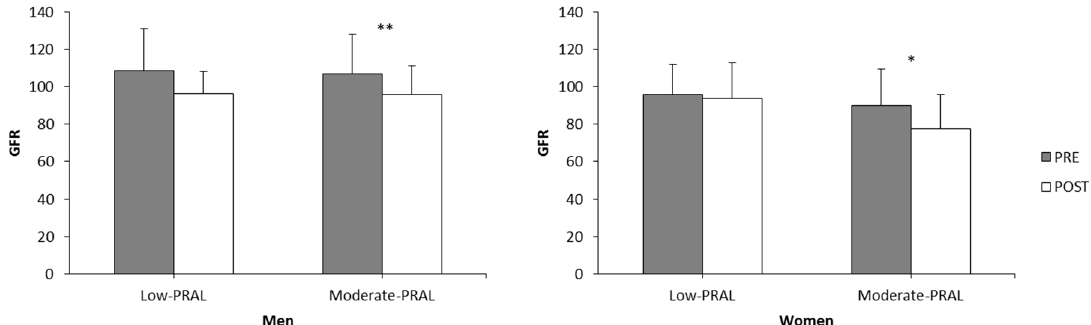
Figure 4. Glomerular filtration rate (GFR) in the low-PRAL and moderate-PRAL groups before (PRE)